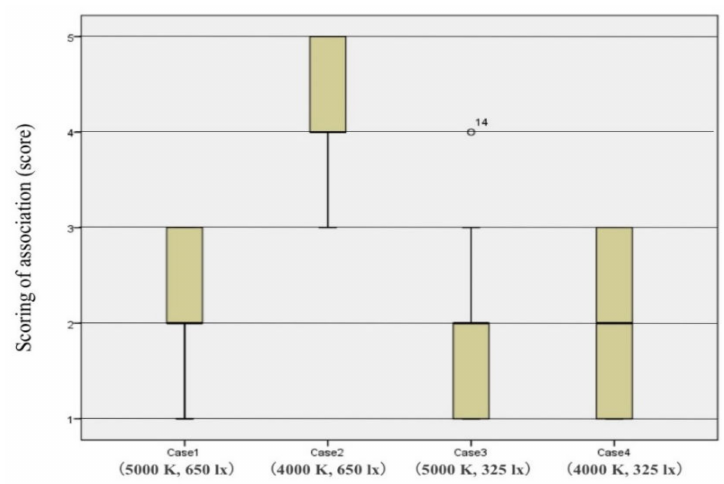
Figure 9. Comparison of subjective evaluation on “association” in di ff erent illumination